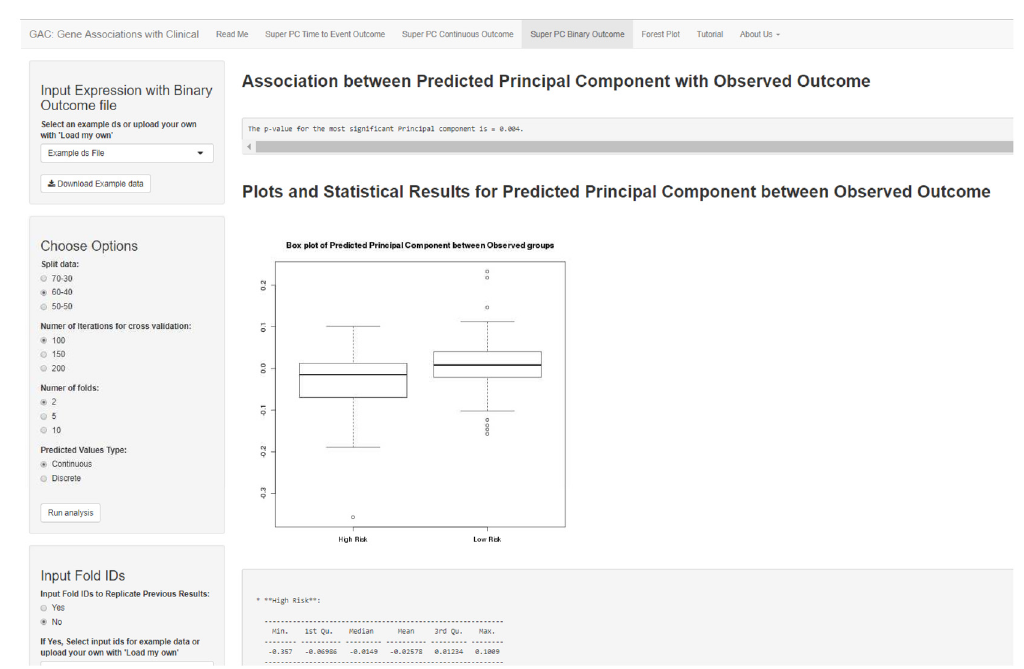
Figure 3. SuperPC binary outcome. The interface shows an example SuperPC for binary outcome. The user can opt for similar options as in the previous figures. Also, as in Figure 2, the user has a choice to display the continuous predicted principal component as a scatter plot, or divide it into binary discrete groups (using median cut-off) to represent the association through a barplot. Similar download options are available.